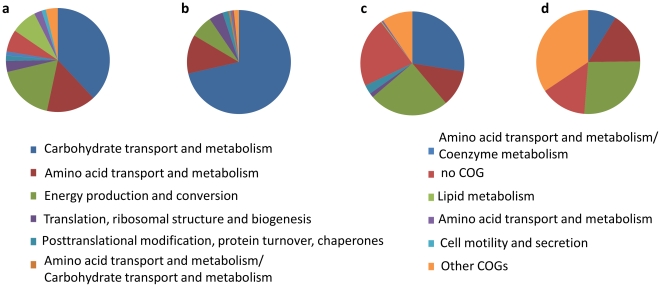
COG distribution per phylum.The COG functional category distribution per phylogenetic group, based on the peptide measurements, is visualized. a) Firmicutes, b) Actinobacteria, c) Bacteroidetes and d) Proteobacteria.